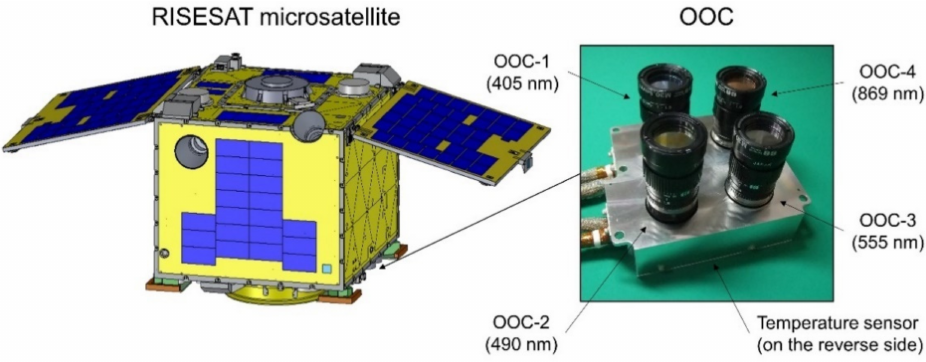
Figure 1. An overview of the RISESAT microsatellite and the Ocean Observation Camera (OOC) with its four cameras each corresponding to different spectral bands.